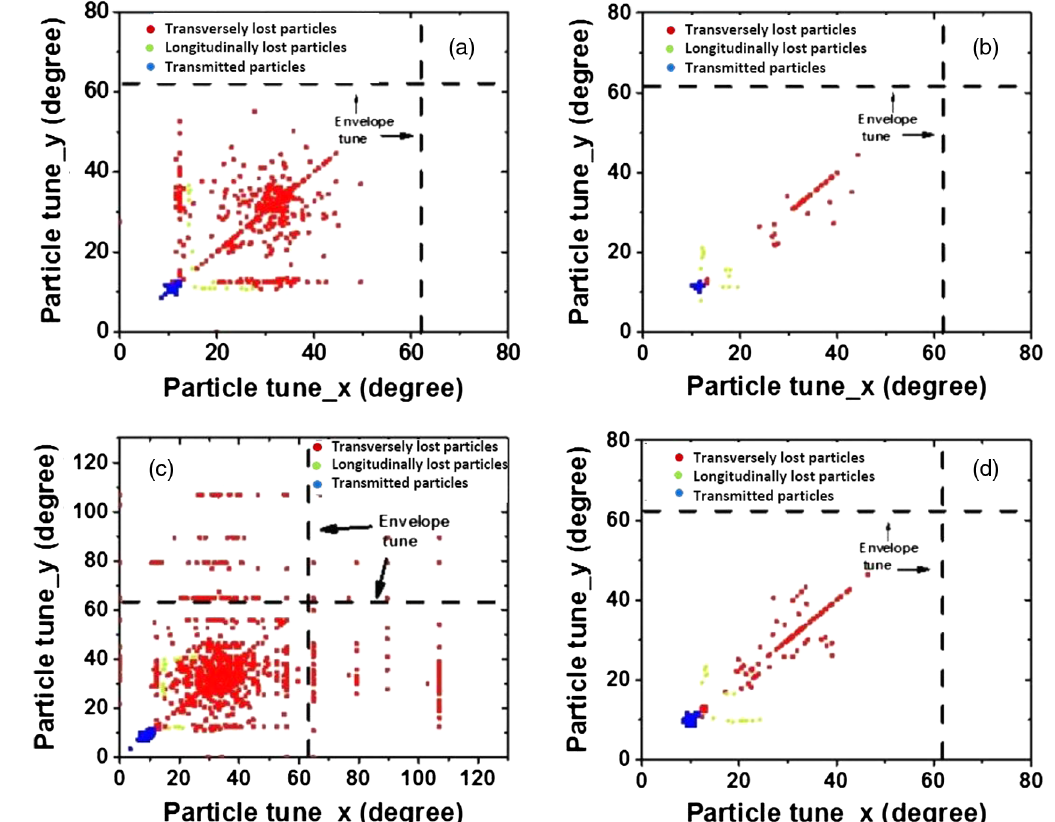
FIG. 11. Plots of the x - y tunes of lost particles, (a) Gaussian beam, no mismatch, (b) HOMB, no mismatch, (c) Gaussian beam, 30% initial mismatch, (d) HOMB, 30% initial mismatch.